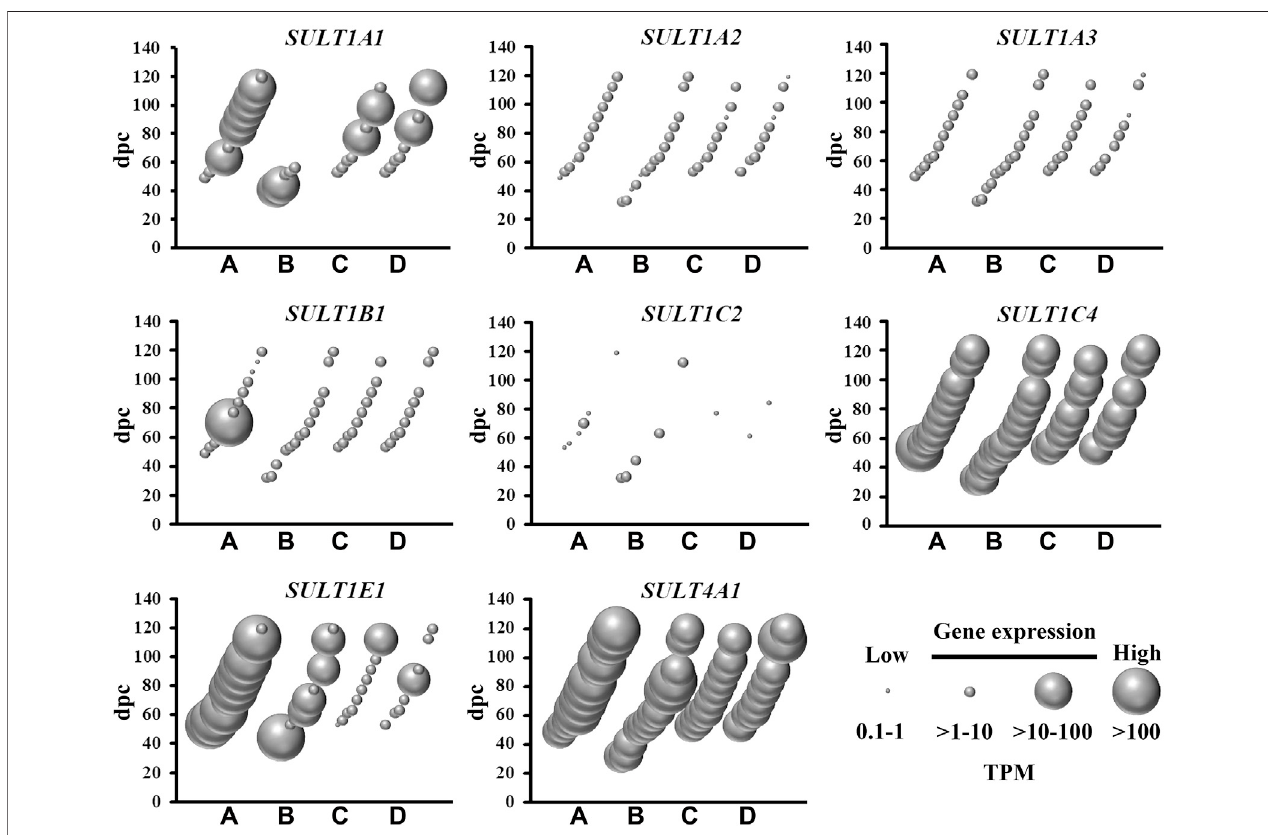
FIGURE 2 | Spatial and temporal mRNA expression of cytosolic sulfotransferases in fetal brain regions (A) cerebrum, (B) brainstem, (C) diencephalon, and (D) cerebellum. dpc, days post-conception. TPM, transcripts per million.